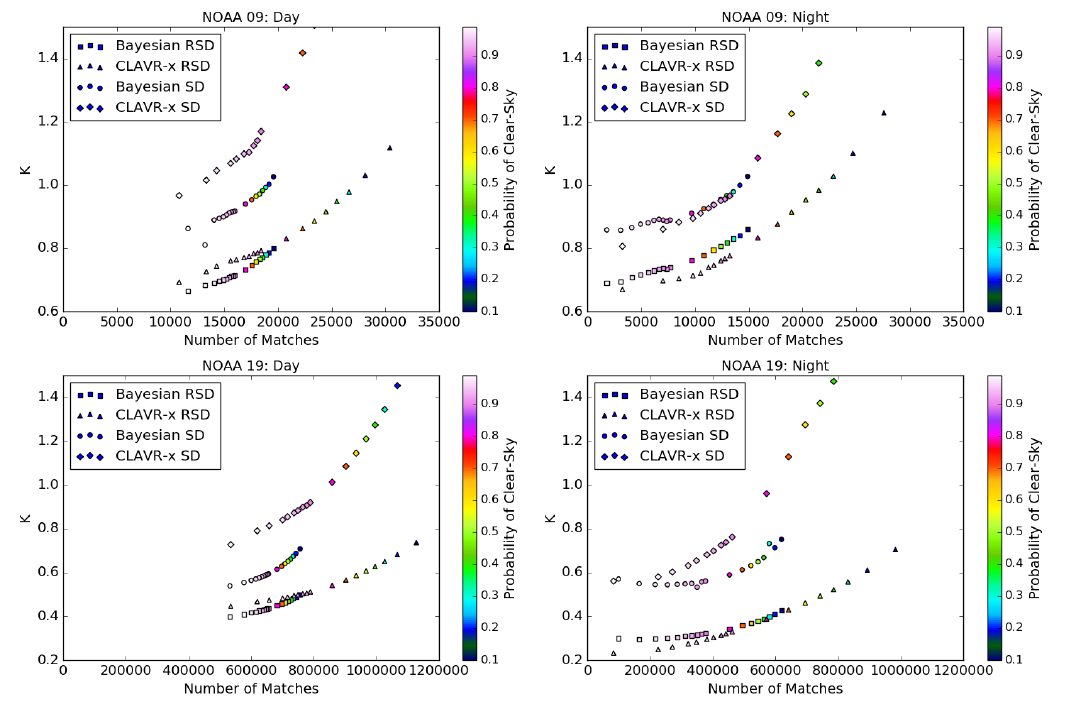
Figure 6. Standard deviation (SD) and robust standard deviation (RSD) of the satellite minus in situ SST differences against drifting buoys for NOAA-09 ( top ) and NOAA-19 ( bottom ). Results are shown for daytime ( left ) and nighttime ( right ) retrievals. The SD and RSD values are plotted as a function of the number of matches and the probability of clear-sky. The clear-sky probability is denoted by the colour of each symbol, and the shape refers to the the mask (Bayesian, CLAVR-x) and the statistic (SD, RSD) as shown in the